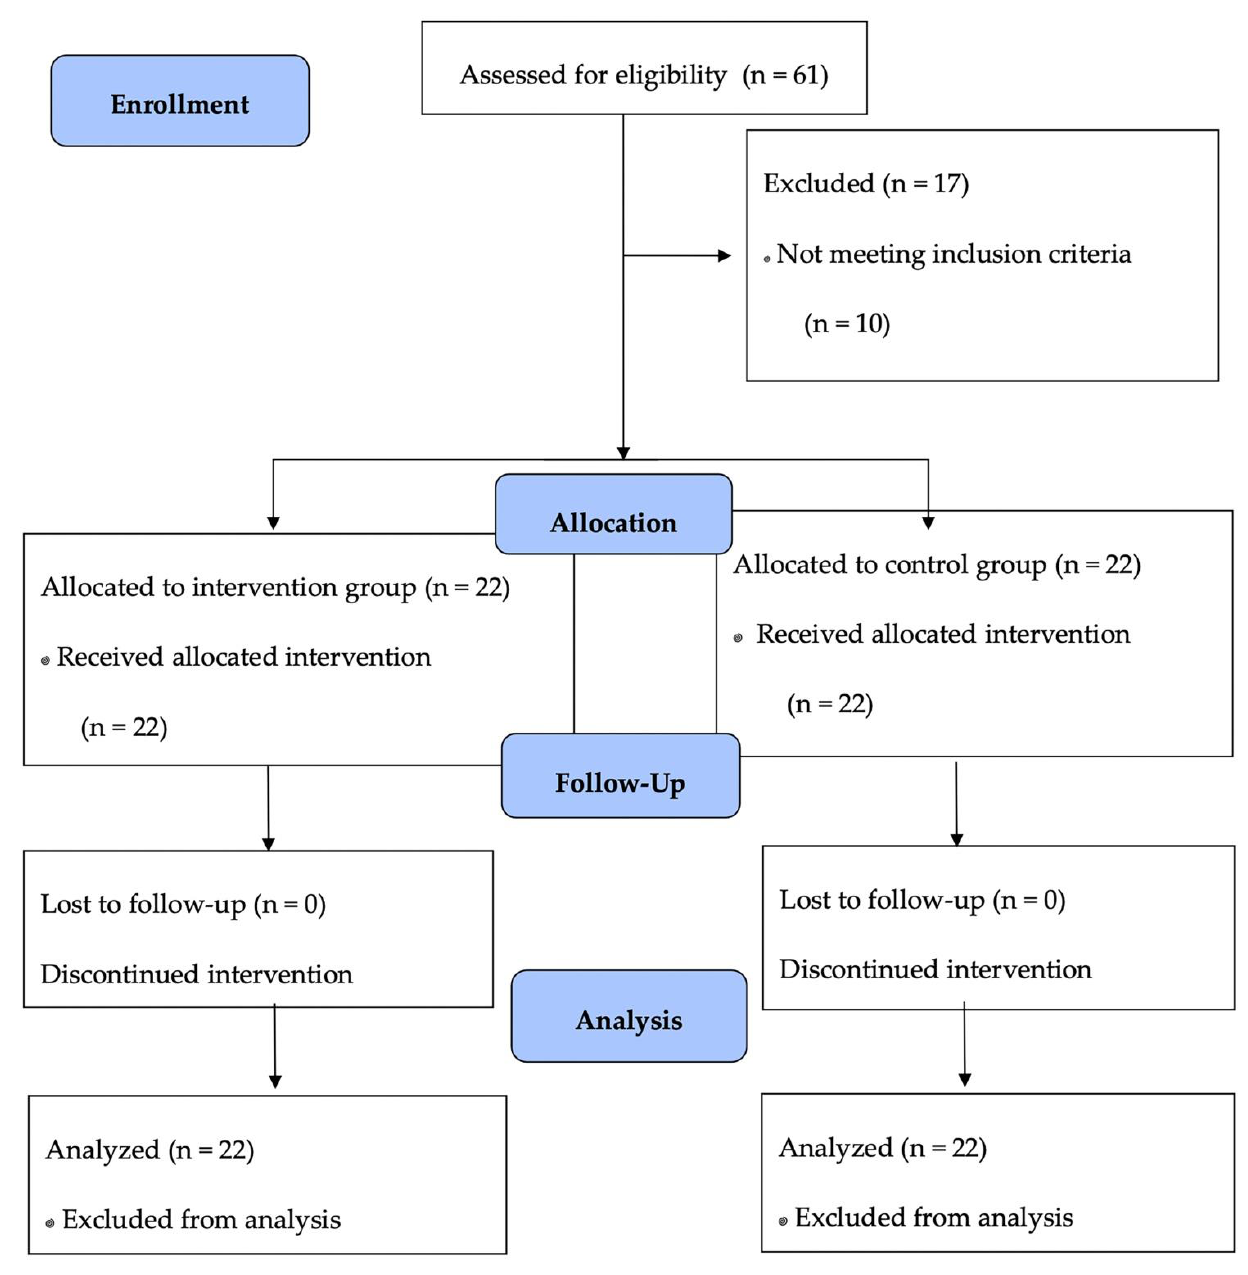
Figure 1. Participant flow.